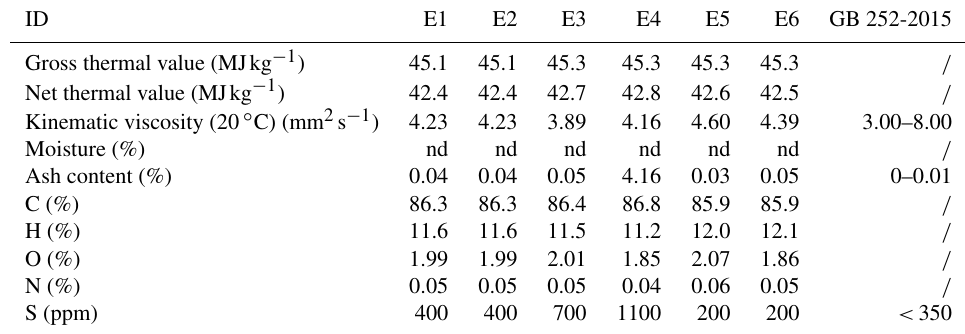
Table 2. Diesel contents from